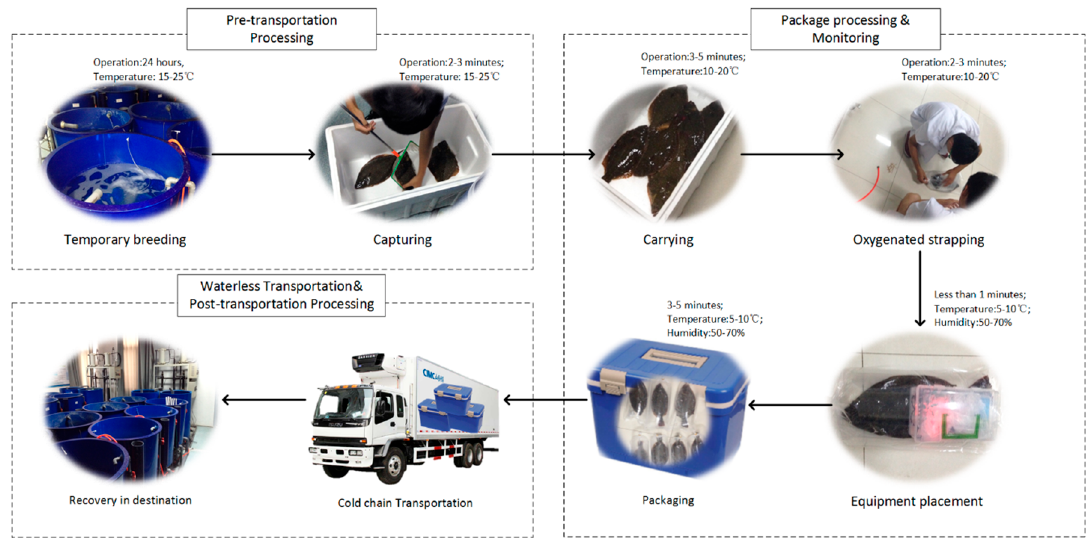
Figure 1. The process of flatfish waterless transportation.